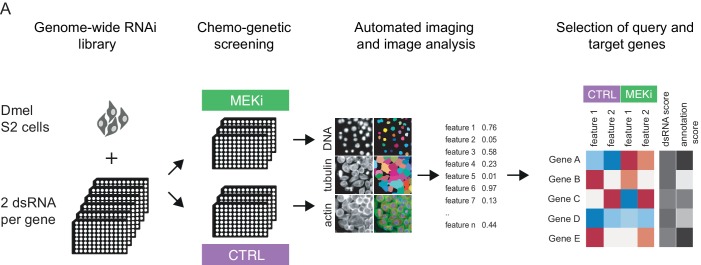
Measuring chemo-genetic interactions by high throughput imaging and RNAi.(A) Schematic representation of the workflow. A genome-wide RNAi library covering 13,617 unique Drosophila genes with two dsRNA constructs was screened in the presence of DMSO (control) or MEKi (PD-0325901) at 1.5 nM. Fixed cells were stained for DNA, actin and α-tubulin and imaged at 20x magnification at a resolution of 2048 × 2048 pixels. Phenotypes were analyzed by automated image analysis of cell morphology on a single-cell level using an R/EBImage pipeline. Genes were rank ordered for co-RNAi screening by dsRNA score (quality and differential phenotype) and gene annotations (unknown genes favored).